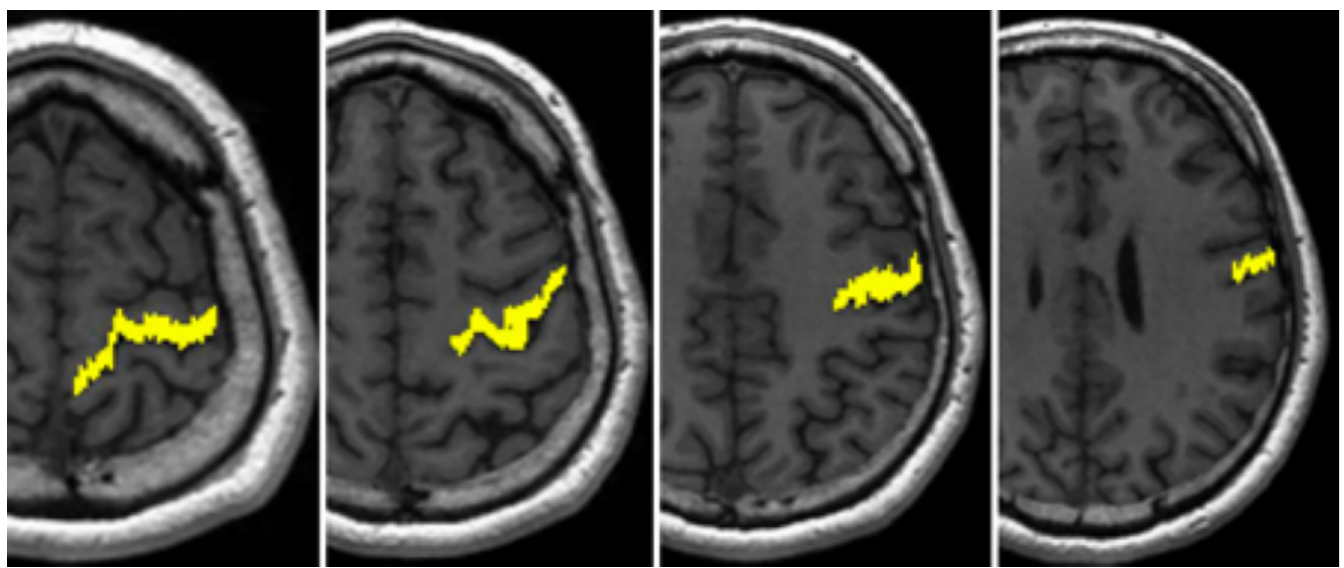
Fig 2. Precentral gyrus waypoint ROI for an example subject shown over a series of axial slices.